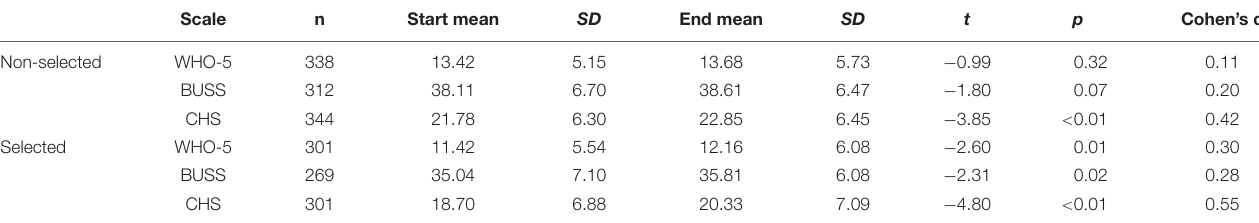
TABLE 3 | Descriptive statistics for main study by student selection